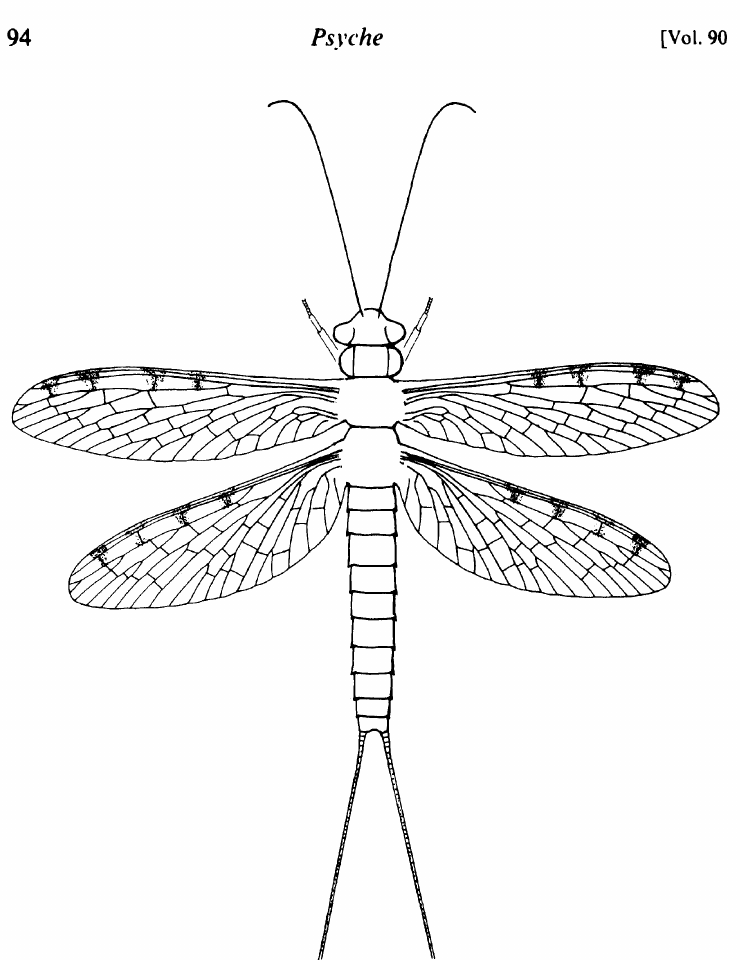
Figure 8. Eubleptus danieisi. Reconstruction based mainly on specimen PHI5, in the Paul Harris collection, with some details from specimens PE32046,PE32245, PE22016, YPMI8, USNM35576,FTWolff 229 and 233, HTP 422, and Bandringa 66-PBSM. All structures shown are preserved in at least one of these fossils. Length of fore wing, 13